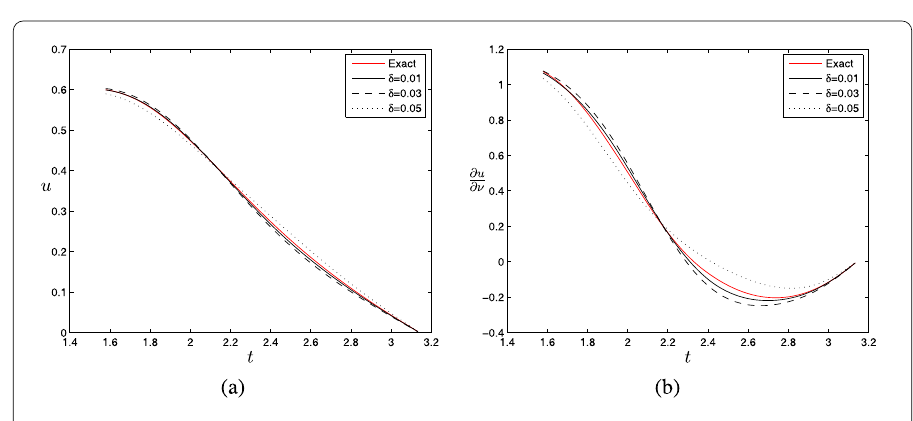
Figure 7 Example 4: The exact solution and the numerical solutions on Γ